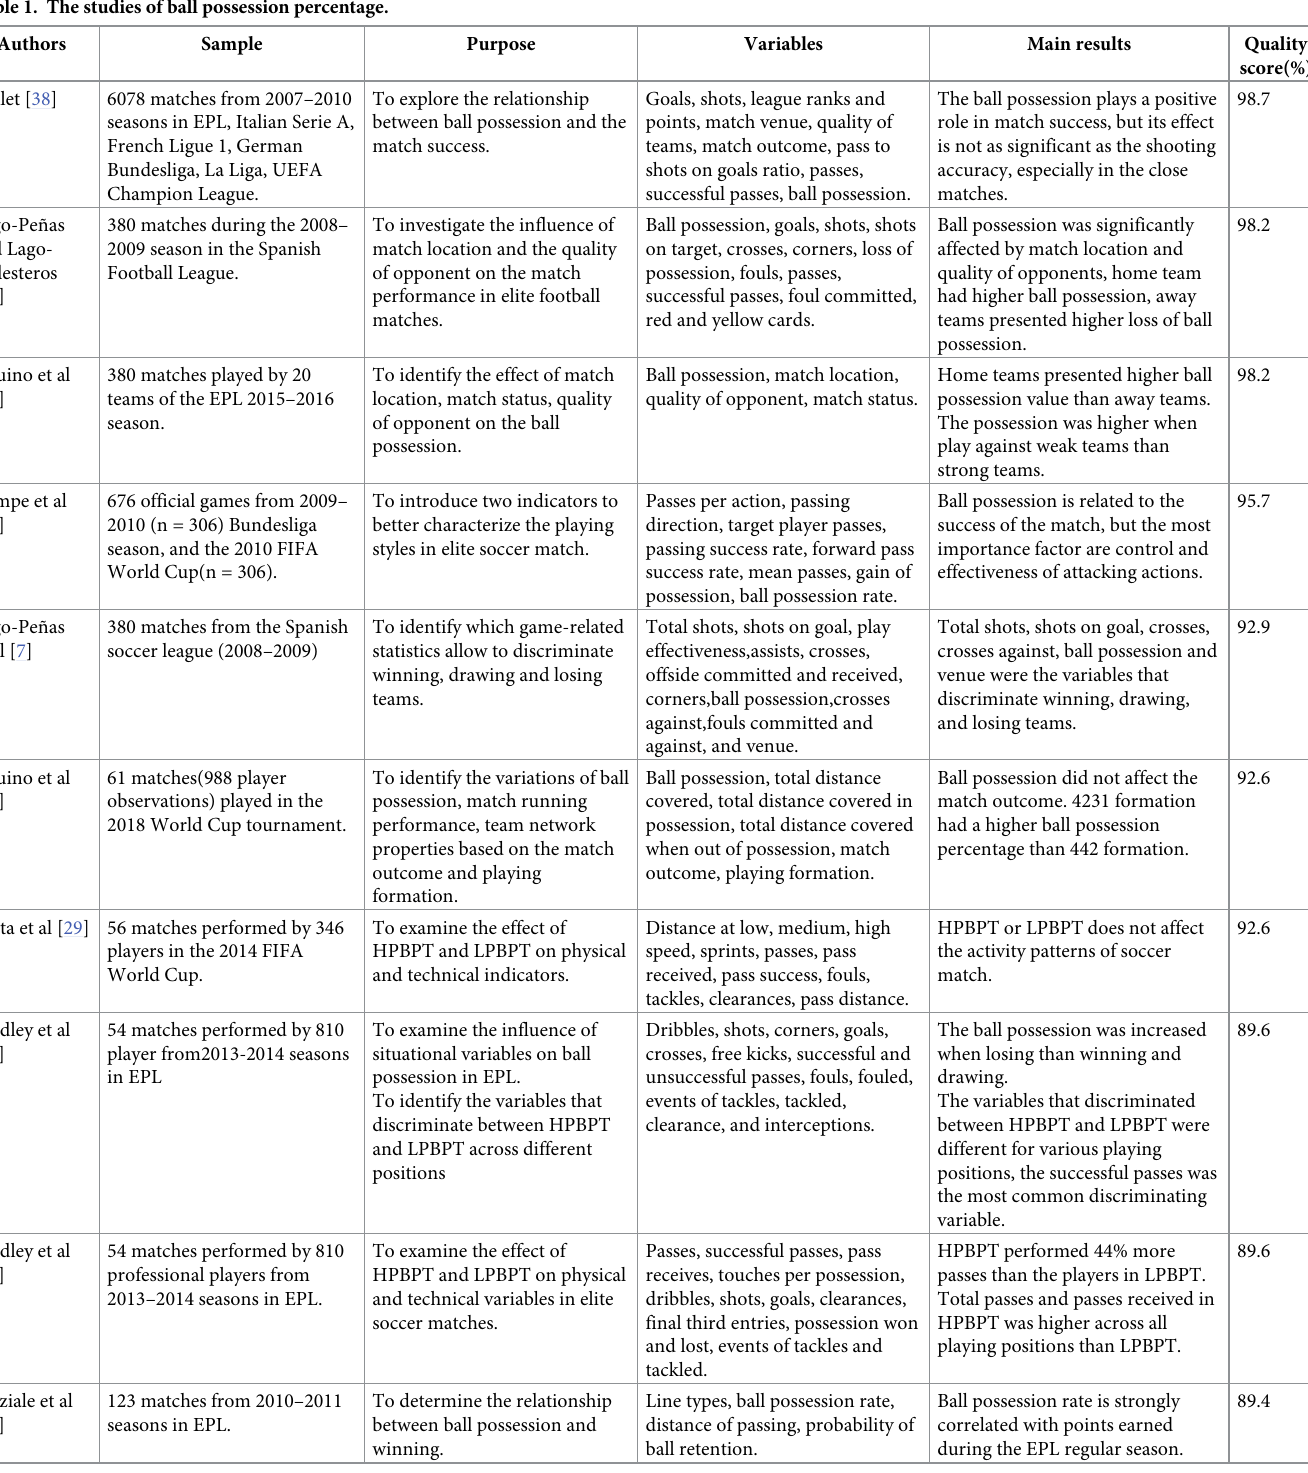
Table 1. The studies of ball possession